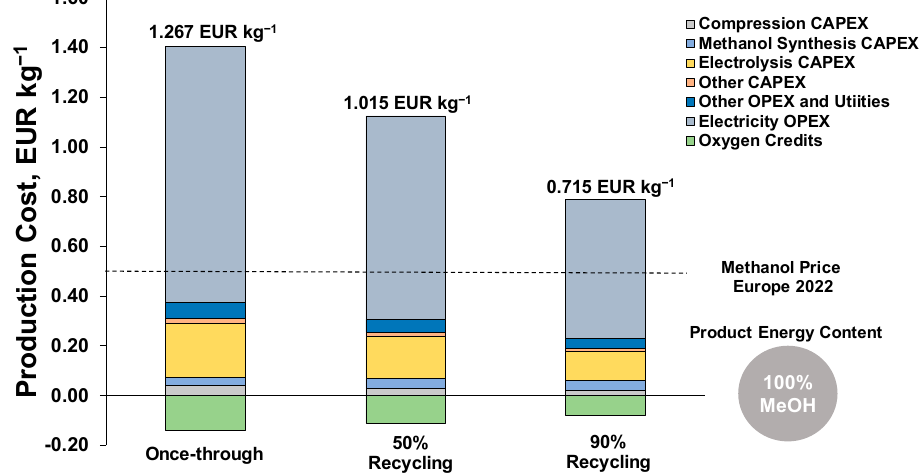
Figure 12. Effect of the stoichiometric number on methanol production costs in the MeOH case.